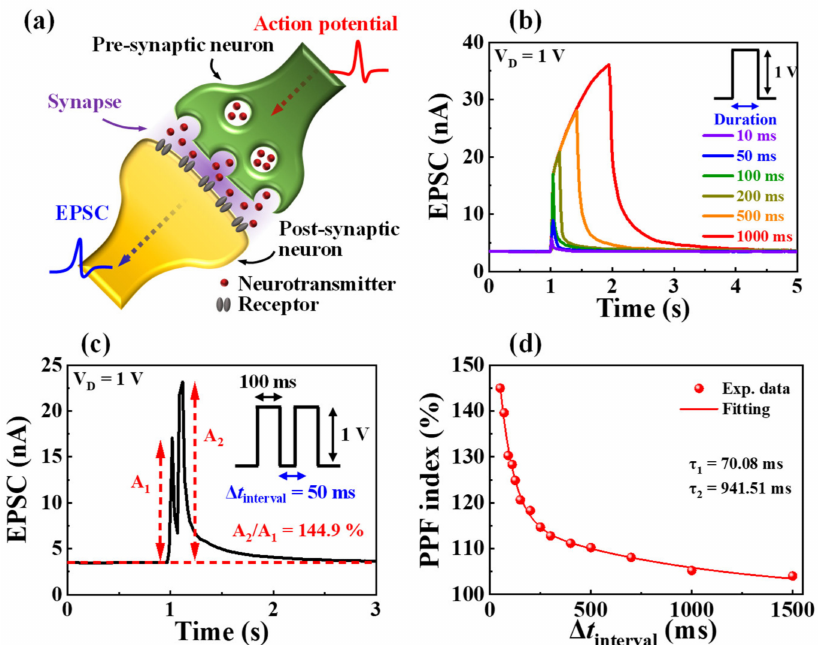
Figure 4. ( a ) Schematic of a biological synapse. ( b ) Excitatory post-synaptic current (EPSC) generated by a single pre-synaptic spike fixed amplitude (1 V) over various durations (10 to 1000 ms). ( c ) Paired pulse facilitated EPSC by a paired pre-synaptic spike (1 V, 100 ms) at ∆ t interval = 50 ms. ( d ) Paired pulse facilitation (PPF) index (A 2 /A 1 ) plotted against various spike time intervals ( ∆ t interval ) from 50 to 1500